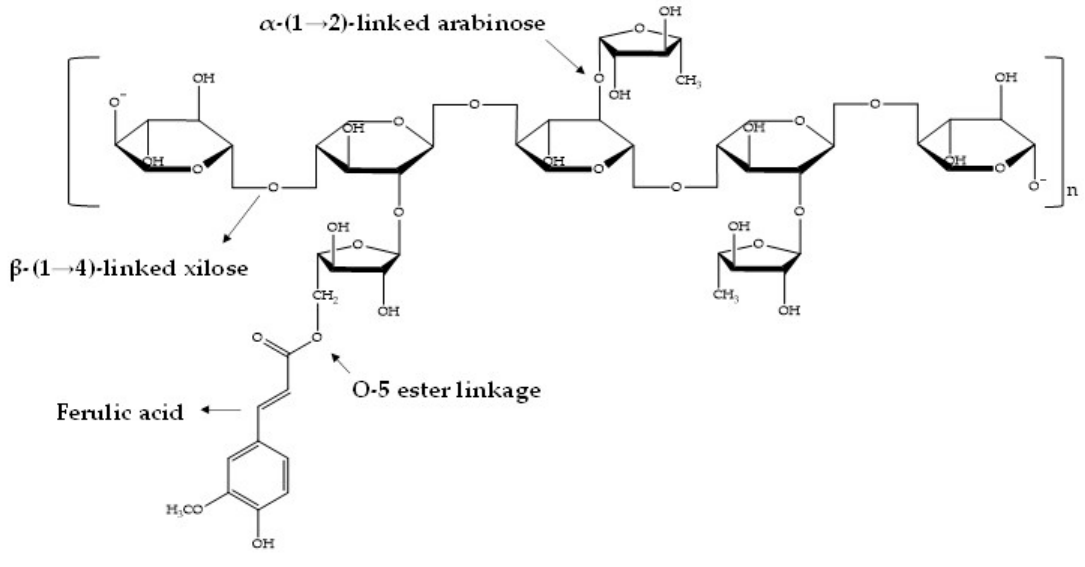
Figure 1. Chemical structure of ferulated arabinoxylan.